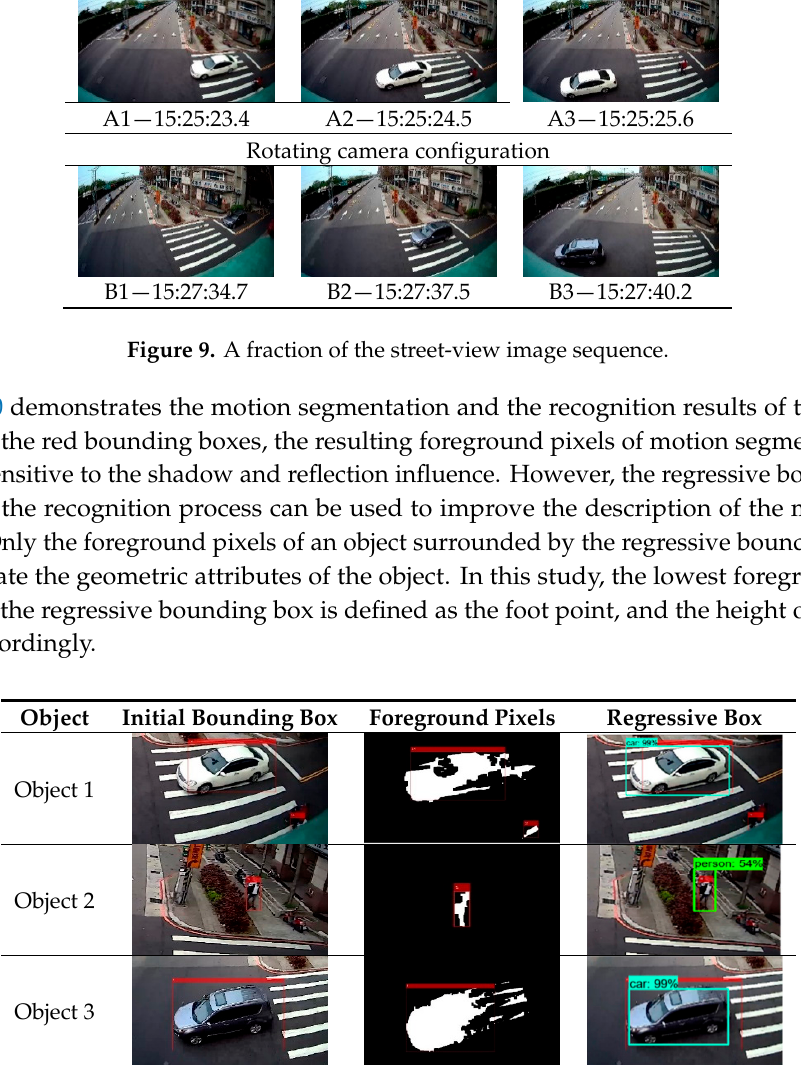
Figure 10. The motion segmentation and the recognition results.